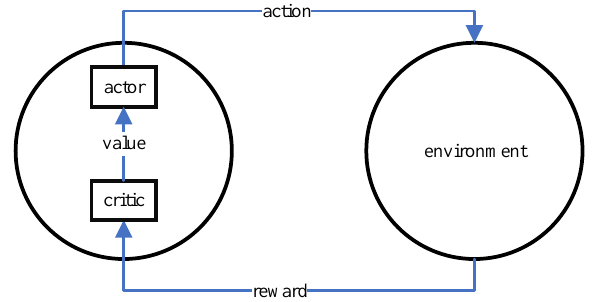
Figure 3. The main components in Actor-Critic and its execution